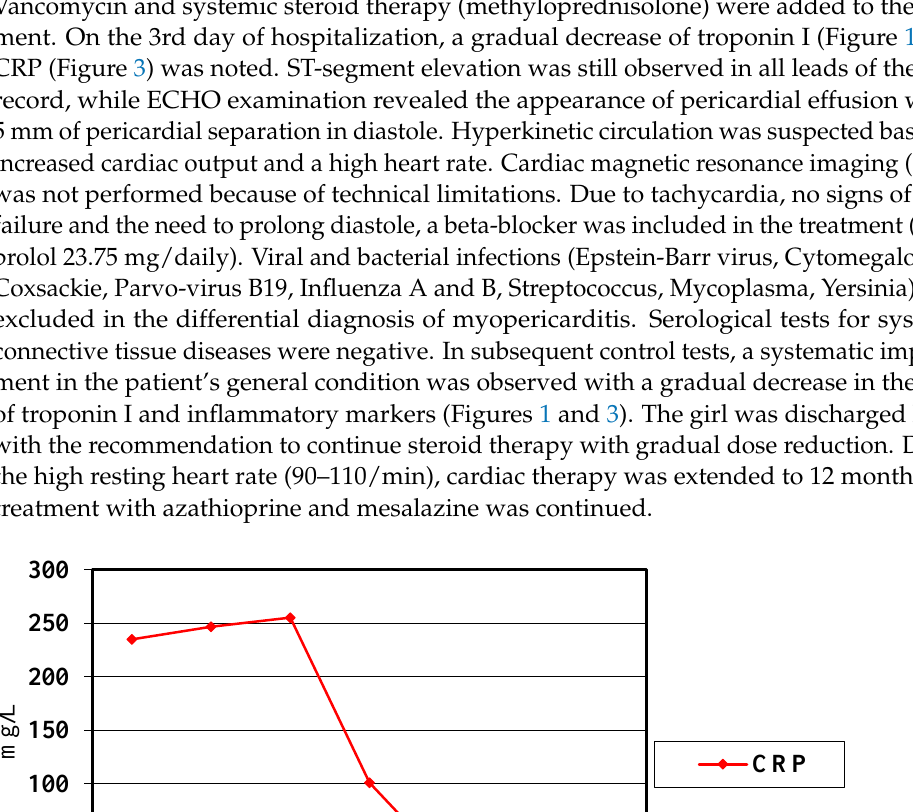
Figure 3. CRP values during observation of myocarditis.